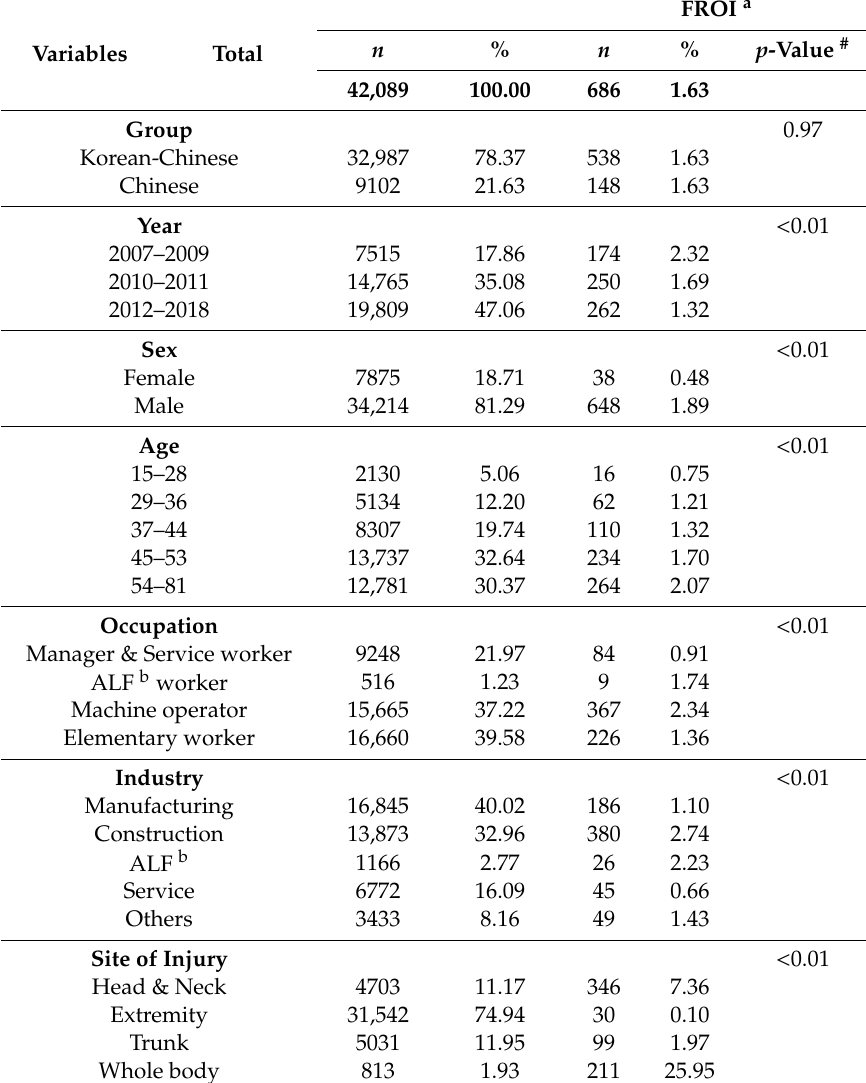
Table 1. FROI a according to subjects’ characteristics ( n =